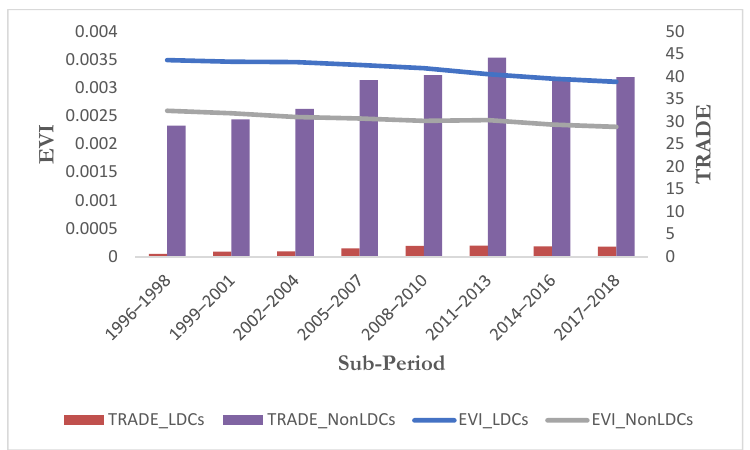
Figure 1. Development of EVI and “TRADE” over the full sample. Source: Author. Note: “FULL” means full sample.